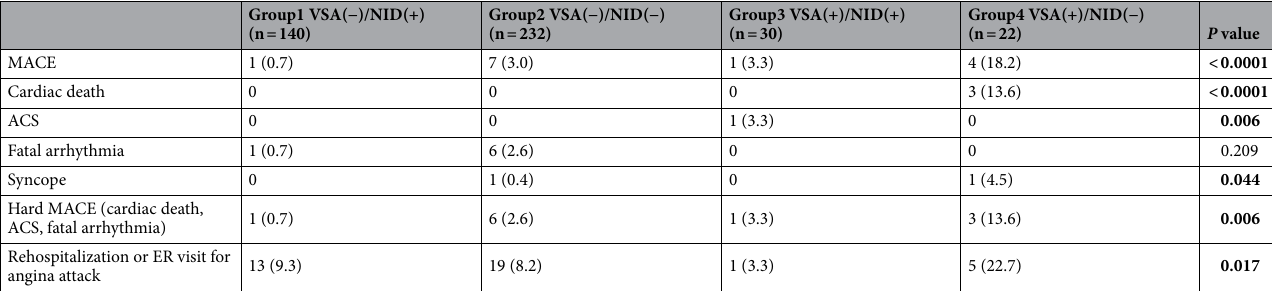
Table 7. Clinical outcomes between 4 groups derived from the combination of VSA and NID results. Data are expressed as numbers (percentages). Abbreviations: VSA vasospastic angina, NID nitroglycerin induced dilation, MACE major adverse cardiovascular event, ACS acute coronary syndrome, ER emergency room. Significant values are in